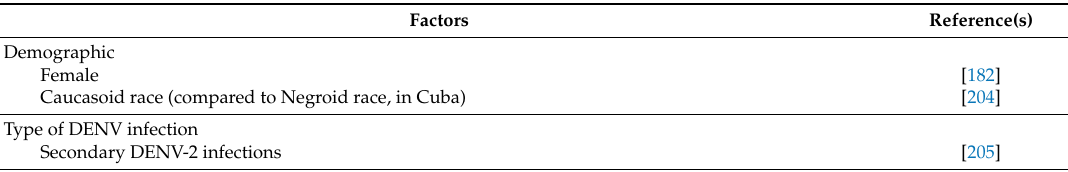
Table 5. Factors associated with mortality or fatality of dengue